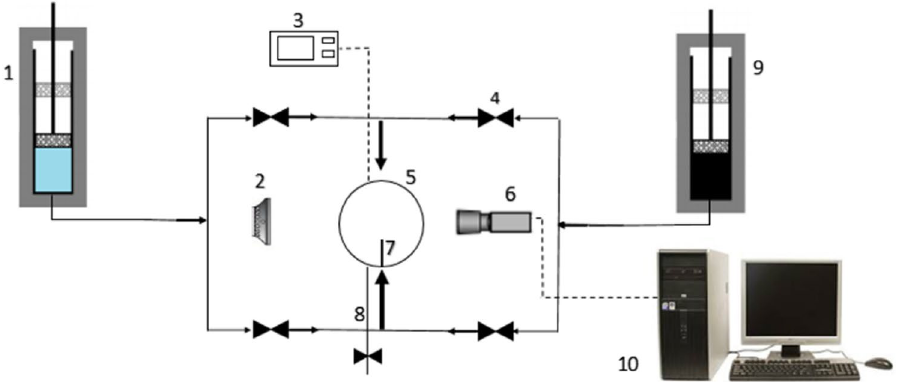
Fig. 2 Schematic of the inter- facial tension and contact angle IFT400. 1: Bulk flow pump. 2: Adjustable light source. 3: Indi- cator and temperature and pres- sure controller. 4: High-pressure valve. 5: Cell. 6: Camera. 7: Drop needle. 8: Cell content drainage line. 9: Drop fluid pump. 10: Computer equipped with device software